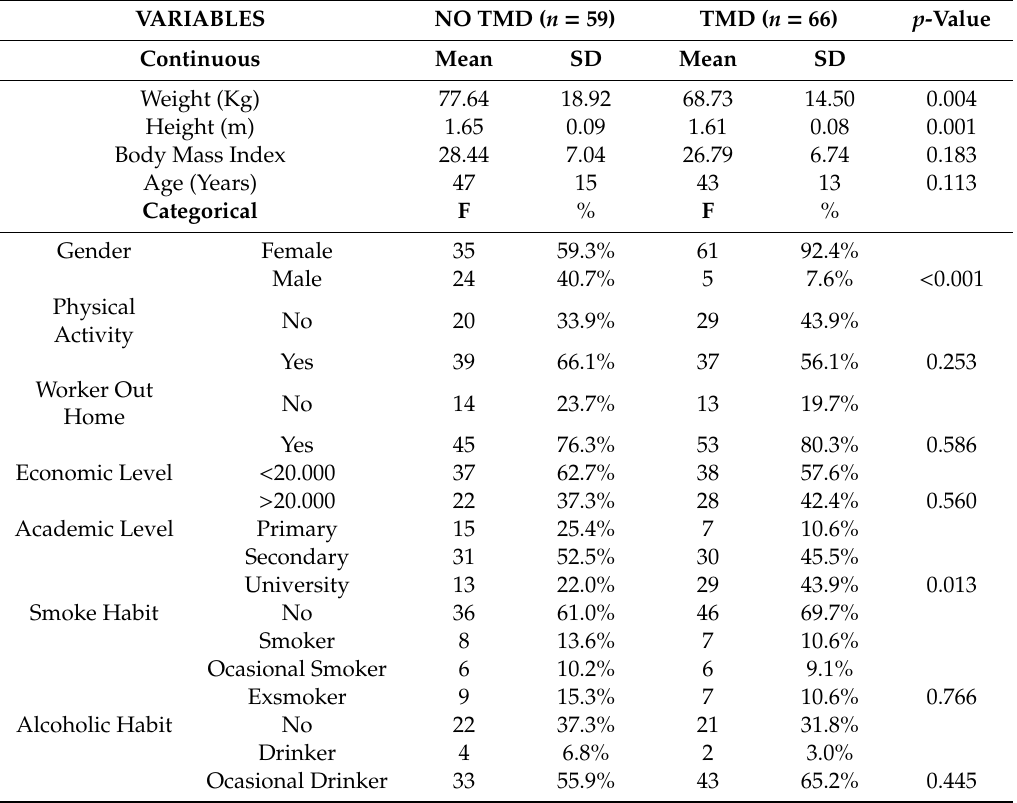
Table 1. Sociodemographic characteristics of the